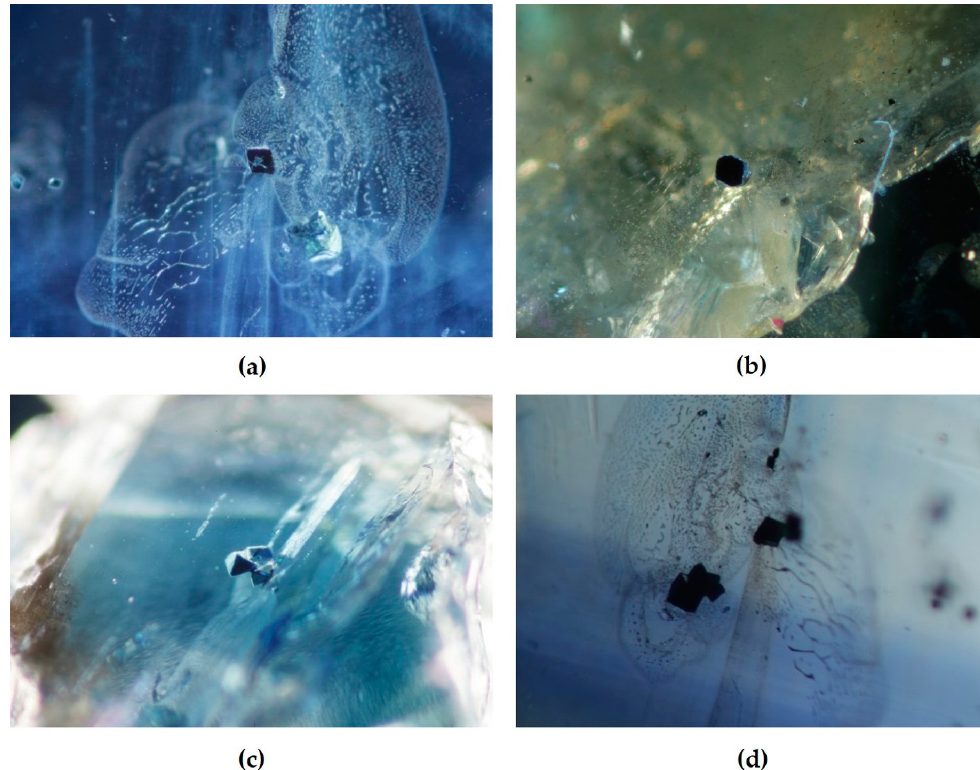
Figure 3. Photomicrographs taken with dark field illumination, magnified 50 × , showing: ( a ) a small octahedral wüstite inclusion in sapphire (sample DL50) from Di Linh; ( b ) a small octahedral hercynite inclusion in sapphire (sample KN43) from Krong Nang; ( c ) aggregate crystals of octahedral wüstite inclusions in sapphire (sample GL27) from Pleiku, and ( d ) aggregate crystals of octahedral hercynite inclusions in sapphire (sample DN16) from Dak